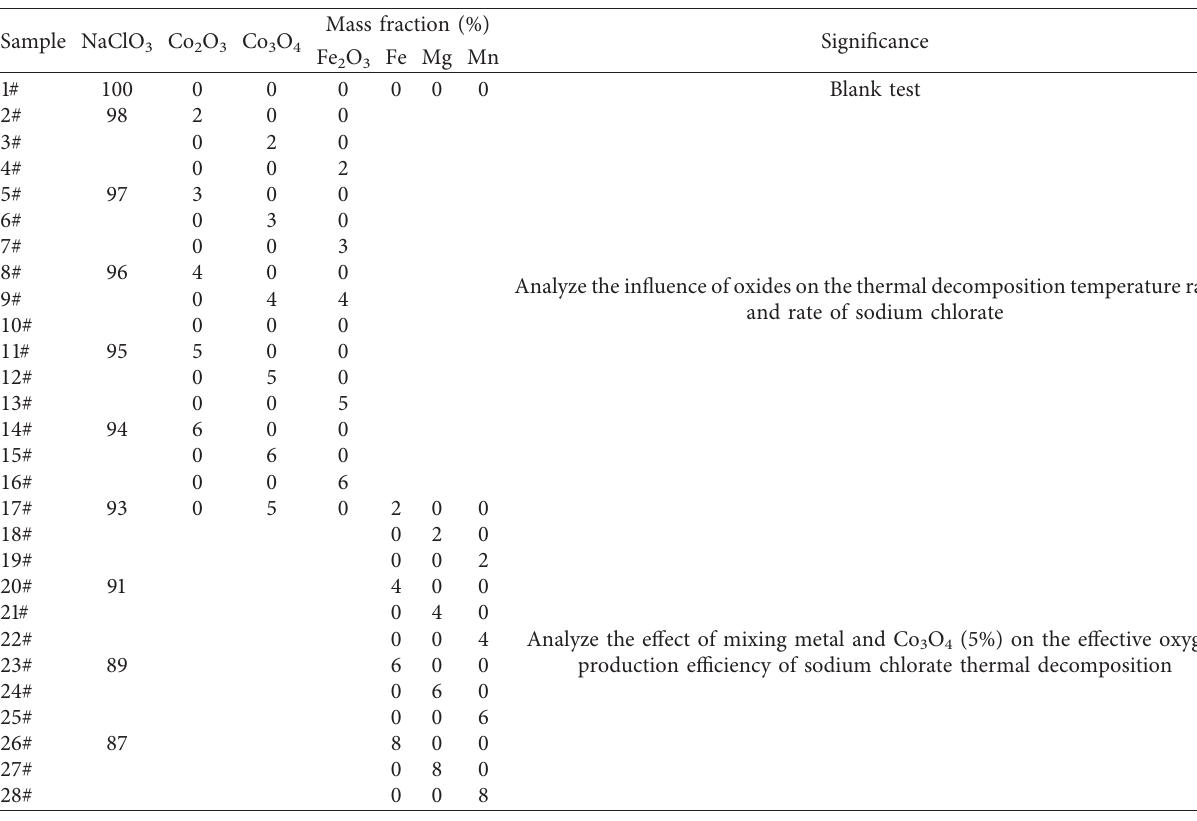
Table 1: Proportioning table for the thermogravimetric experiment.